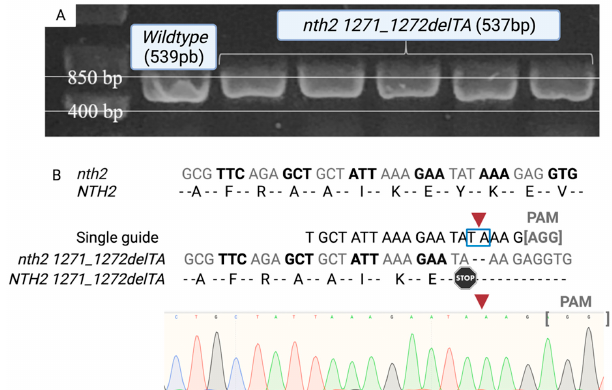
Figure 1. Confirmation of NTH2 gene disruption in S. cerevisiae by CRISPR/Cas9. ( A ). Amplification of the segment containing the expected mutation site on a 1% m/v agarose gel; ( B ). Sequencing of the S. cerevisiae NTH2 gene. In the box, it can be observed how the deletion 1271_1272delTA caused the Y424X mutation in the nth2 1271_1272delTA strain. Image created with BioRender.com (accessed on March 30 th , 2022).